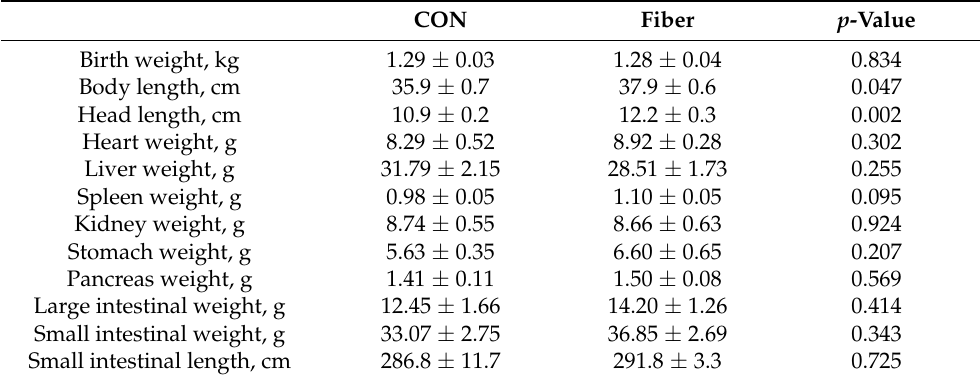
Table 2. Organ index of newborn